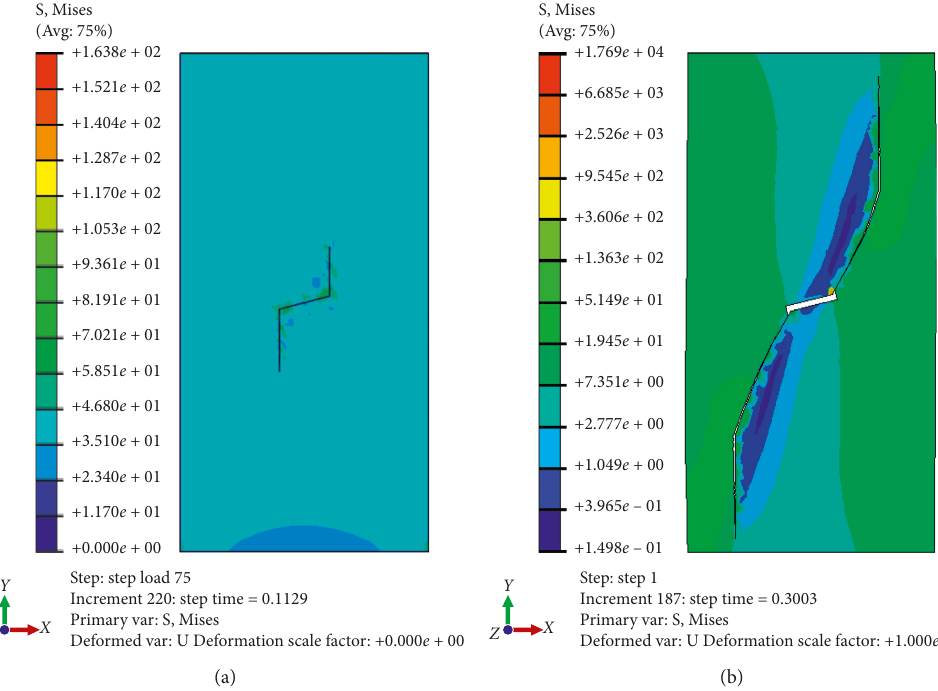
Figure 8: Numerical simulation results of single-crack fracture propagation with β � 75 ° : (a) 0.5mm thick crack ( ρ � 0.25mm); (b) 2.0mm thick crack ( ρ �